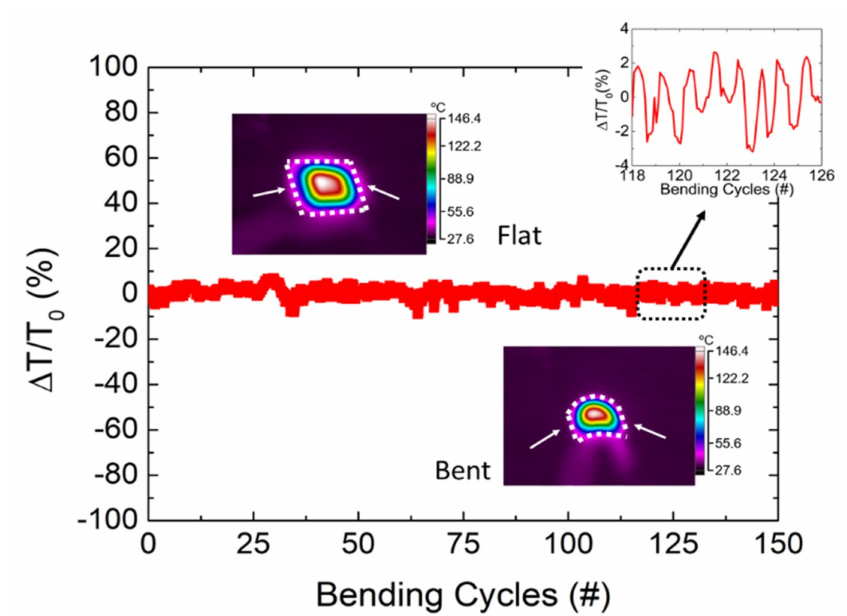
Figure 6. Relative change in temperature with respect to the theoretical steady-state temperature for a driving voltage of 12.5 V while bending. The heater (area: 150 mm 2 ) was bent to a minimum diameter of 10 mm at a bending frequency of 0.5 Hz over 150 cycles (300 s). Insets show the infrared images of both flat and bent states (arrows indicate the contacting